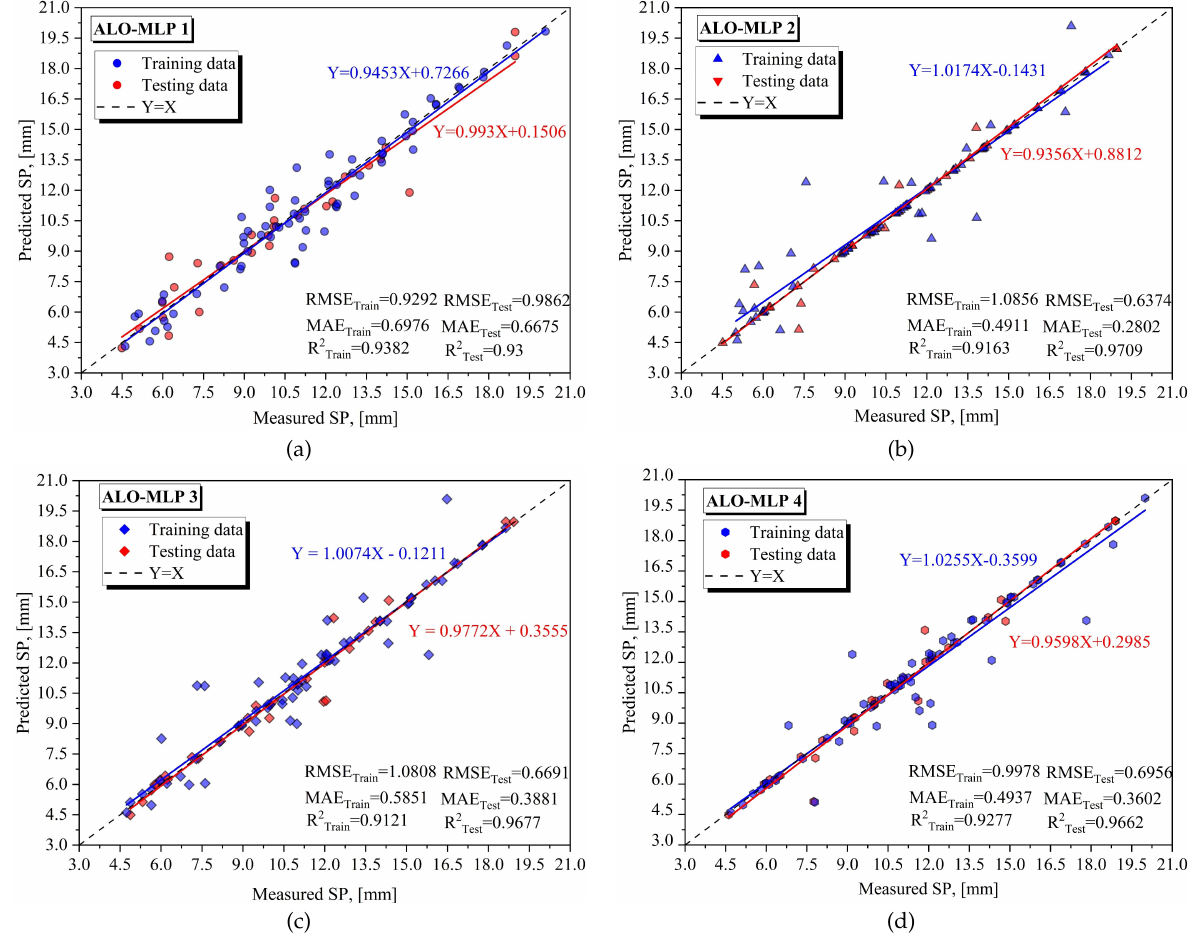
Fig. 8. Comparison between measured and predicted pile settlement for ALO-MLP models Regarding ALO-MLP models in the training phase, MLP model with one hidden layer has the highest R 2 at 0.9382, while the lowest value was for MLP3 (0.9121). For GOA- MLP models, same as ALO models, model with one hidden layer has the best R 2 , but the GOA-MLP resulted the worst correlation value. All in all, it means that the correlation between in-situ SP measured and predicted values is in acceptable relation to show the highest accuracy in the regression